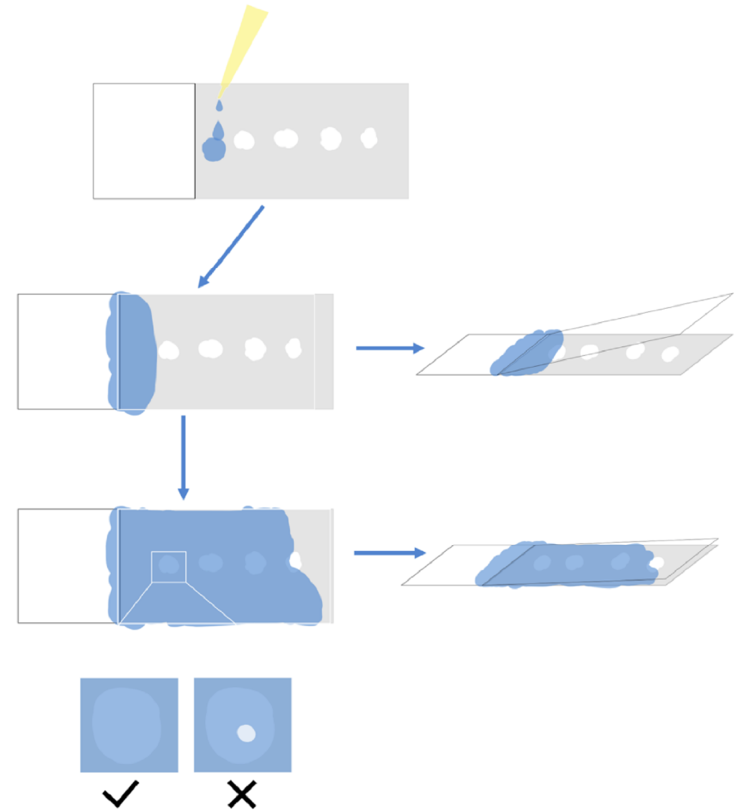
Figure 6. Schematic of the key technical points in the sealing of optimized hybridization incubation. The RNA hybridization liquid drops on the position shown with blue color, and then gently pressing down one side of the cover glass on this side and press it with the left hand to make the cover glass fit the RNA hybridization liquid. Hold the cover glass with the right hand and slowly put down the other layer. The RNA hybridization liquid is pushed away slowly with the cover glass. The moving speed of the cover glass must be slower than that of the RNA hybridization liquid, especially the viscous anti RNA hybridization liquid with glucosamine sulfate.